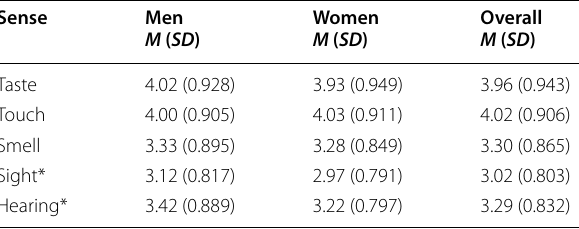
Means range from 1 (significantly decreases) to 5 (significantly increases) with 3 being “does not change”